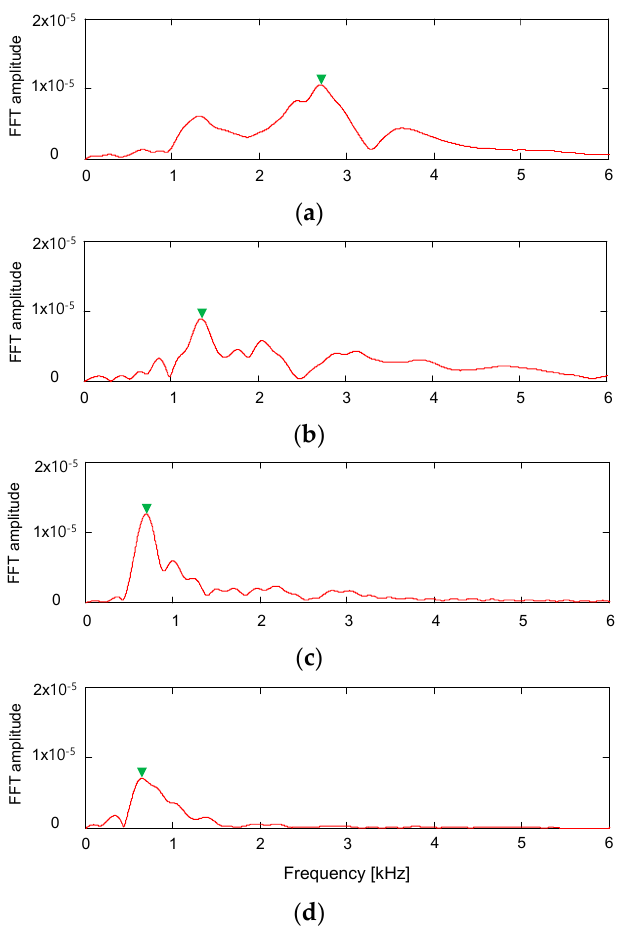
Figure 8. Frequency response curves obtained from the ring bender at the water content of ( a ) 9.3%; ( b ) 9.6%; ( c ) 10.6%; ( d ) 12.4%. FFT denotes fast Fourier transform.